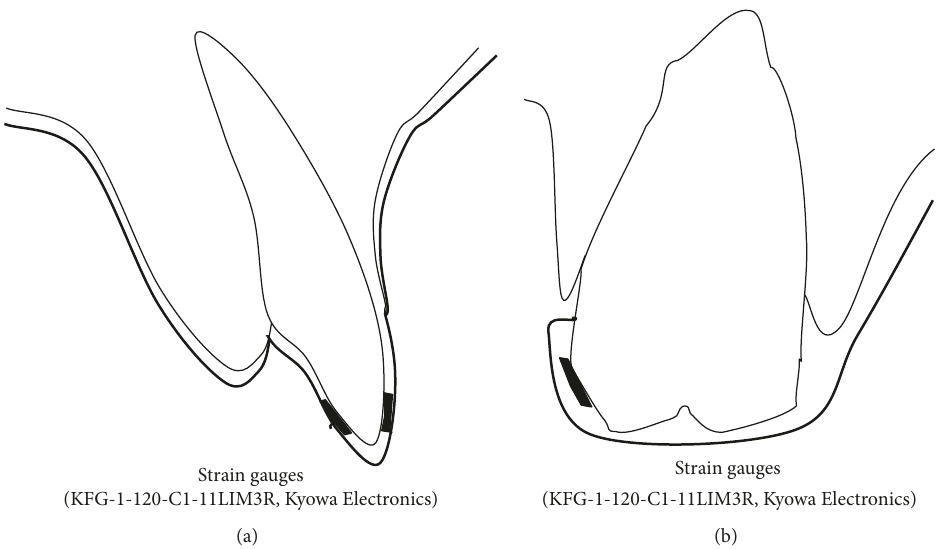
Figure 2: Placement of strain gauges on (a) the central incisor and (b) the first molar. The thick line indicates the OA surface.